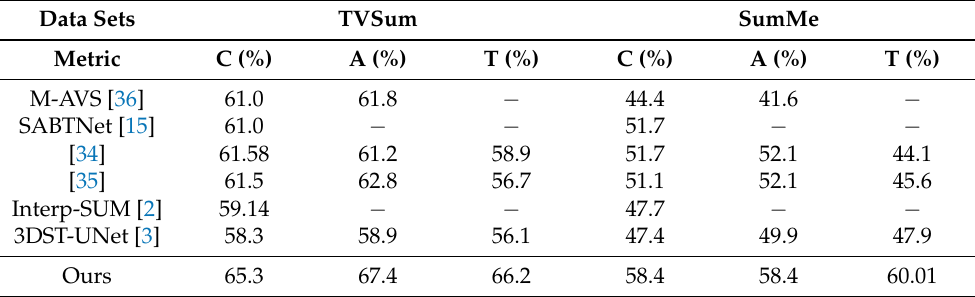
Table 5. Performance analysis of methods based on “Attention+”.